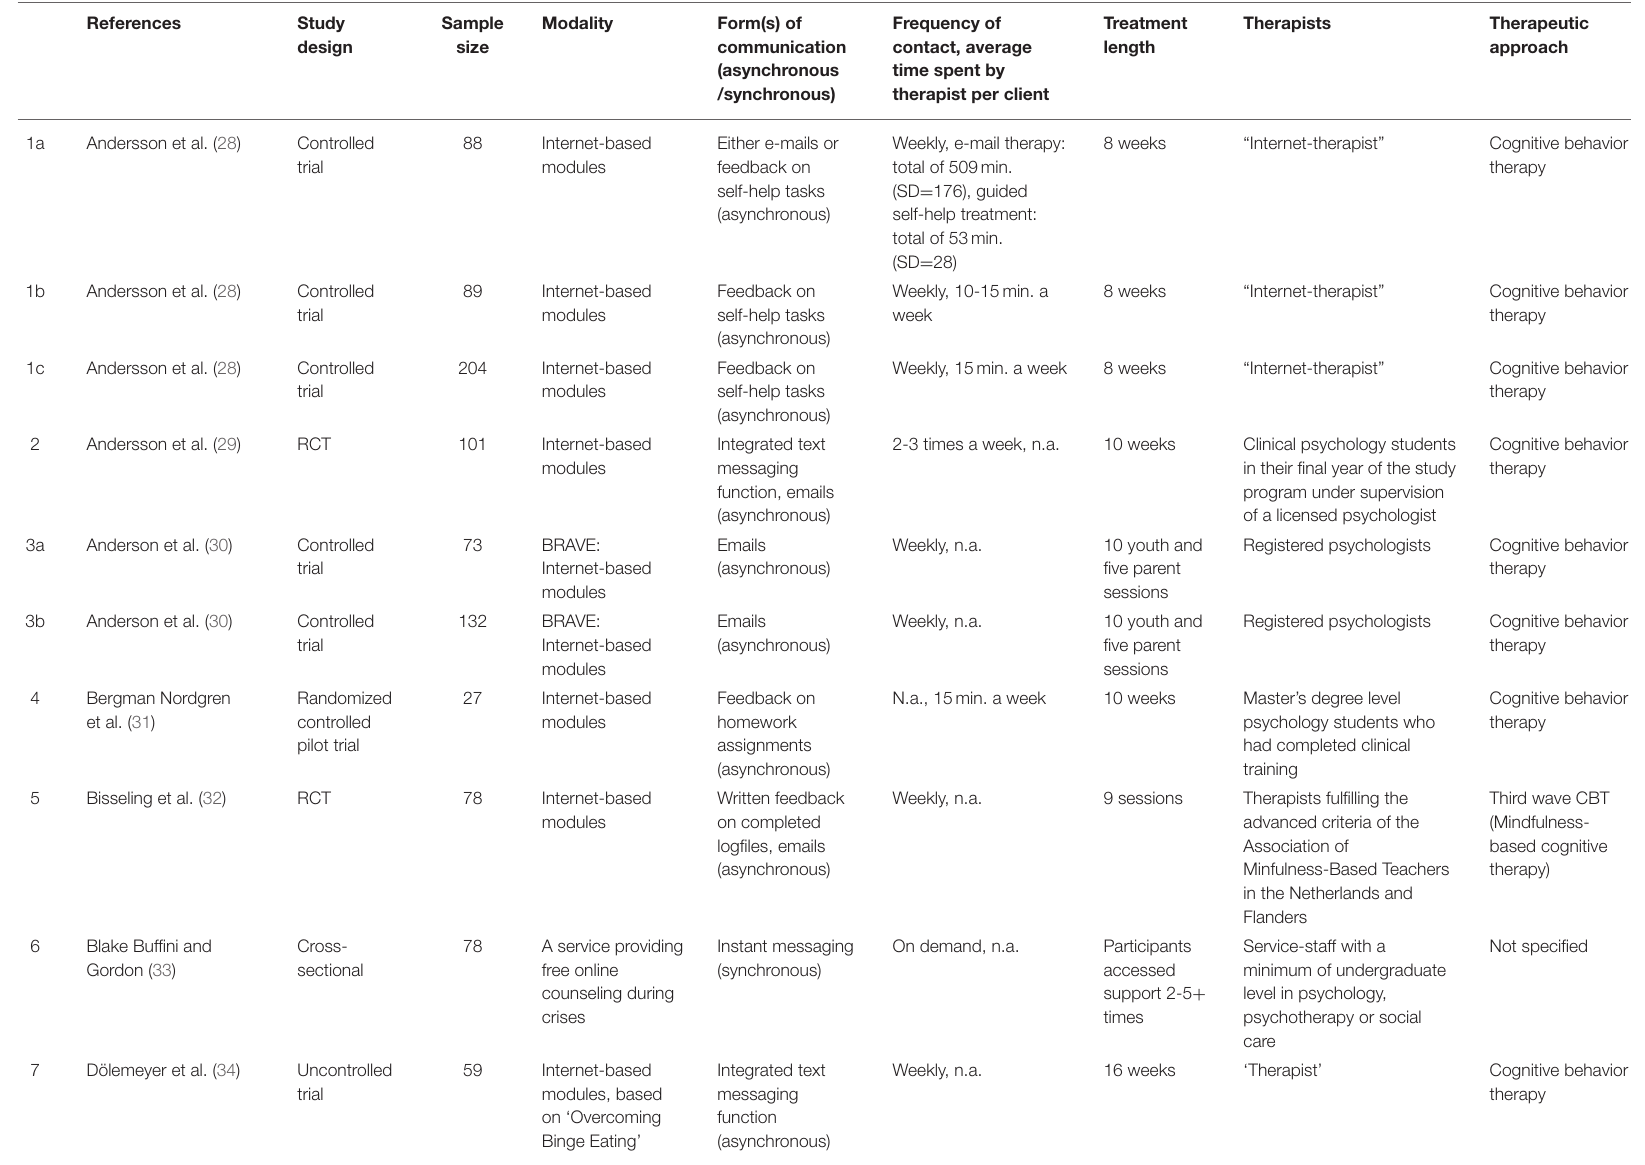
TABLE 2 | Study and intervention